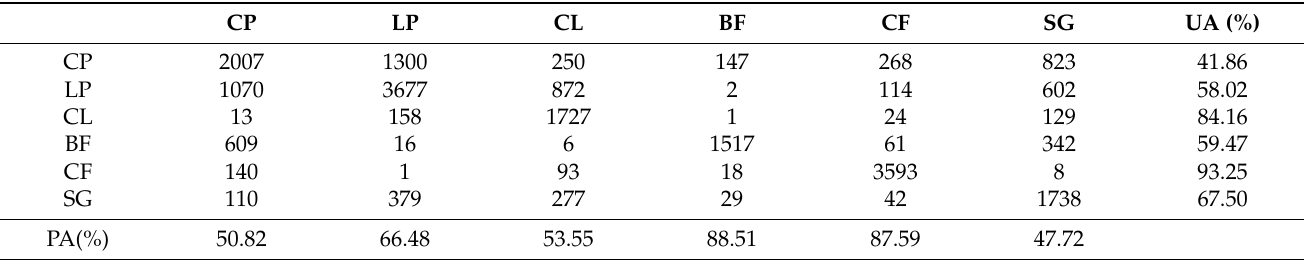
Table 3. Confusion matrix of the classification results of PolSAR data after POA + ESA